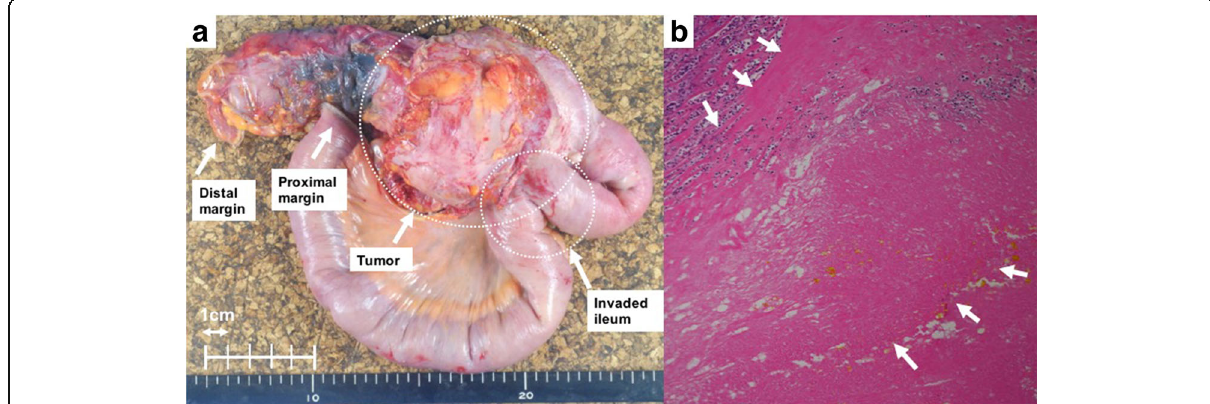
Fig. 4 Macroscopic and microscopic images of resected specimen. a 9.0 × 7.0 cm tumor seemed to infiltrate the ileum. b Histopathologically, no residual cancer cells were found in the giant mass and marked stromal fibrosis replaced the